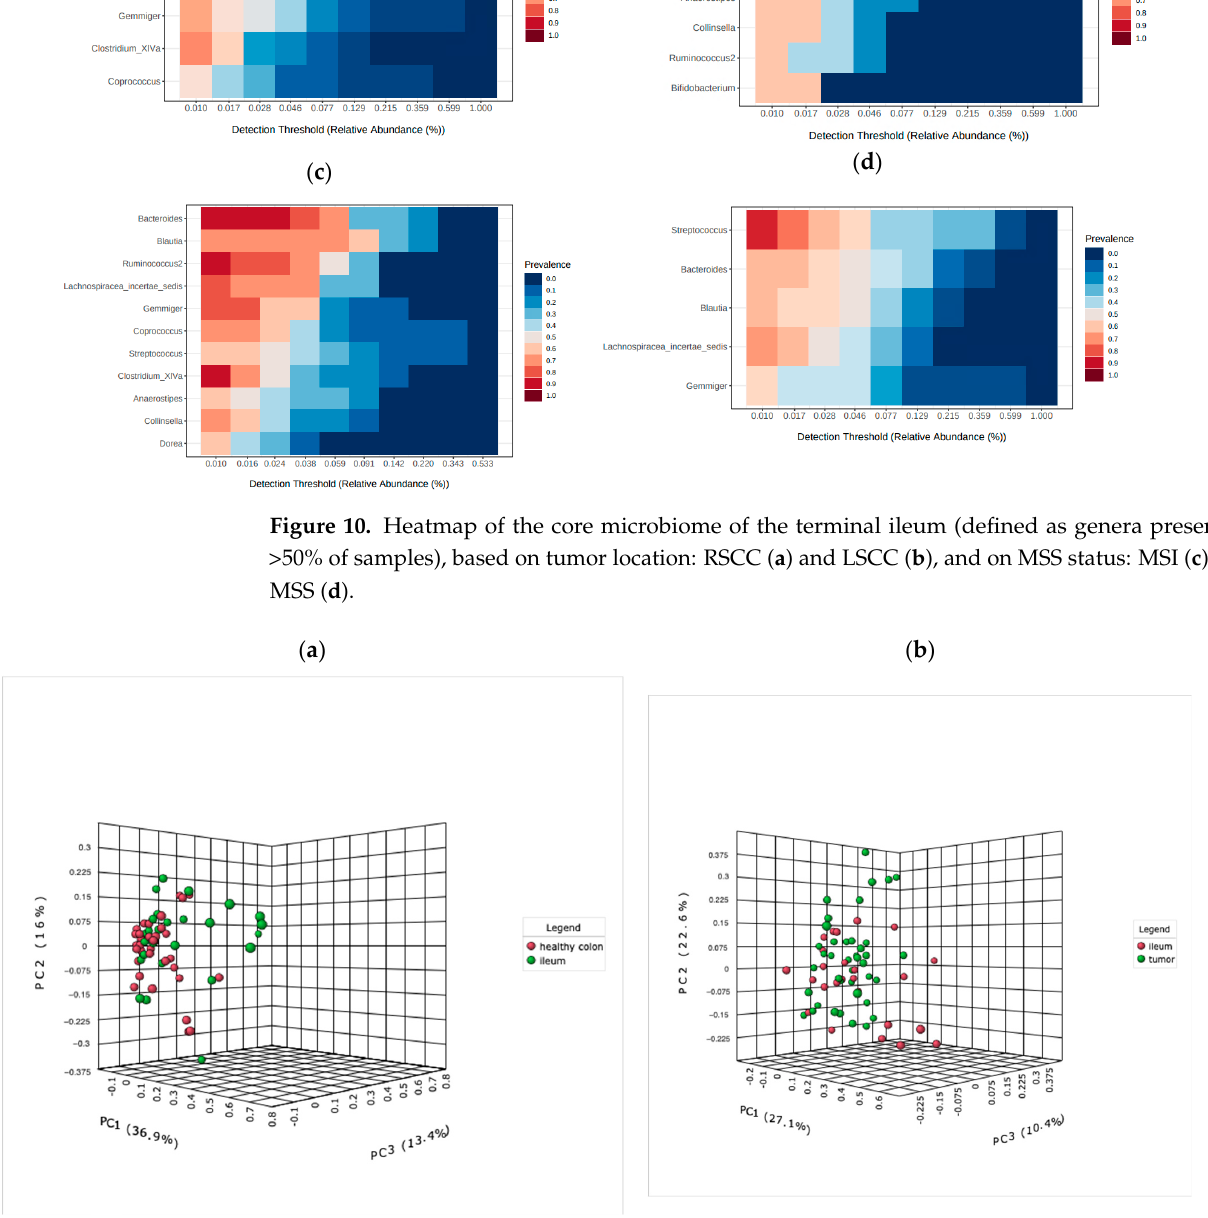
Figure 11. The tumor microbiome–ileal microbiome association: PCoA using Jensen–Shannon di- vergence of beta diversity between ileal and healthy colon tissue was significantly different, p value < 0.05 ( a ), while no significant differences were observed between ileal samples and tumor samples ( b ).